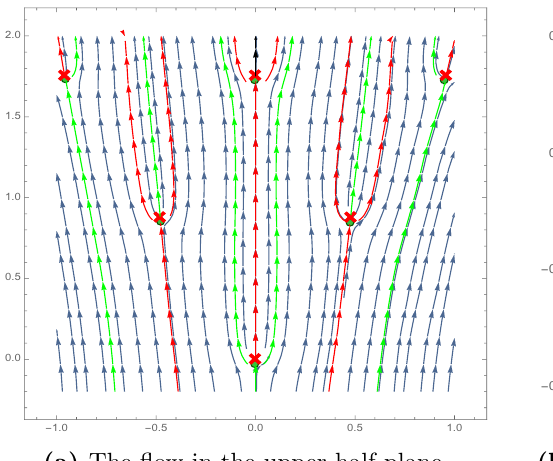
Figure 5. Morse (cid:13)ow for the theory with two chirals, b = e i= 2 , (cid:24) = 12. The green circles are saddles and the red crosses are poles. From each saddle the downward (cid:13)ows (the J cycles) go o(cid:11) to the sides and eventually o(cid:11) to 1 . The upward (cid:13)ows (K cycles) (cid:13)ow up to the nearest pole, and down to either the nearest pole, or past the real axis if they are the lowest saddle in their given topological